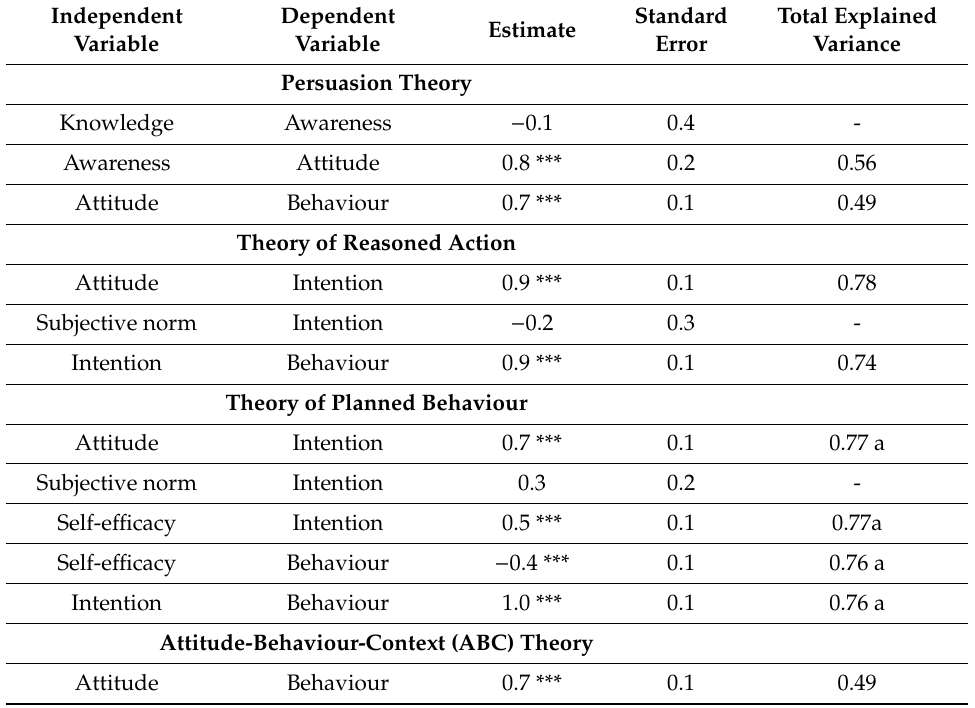
Table 8. Results of regression